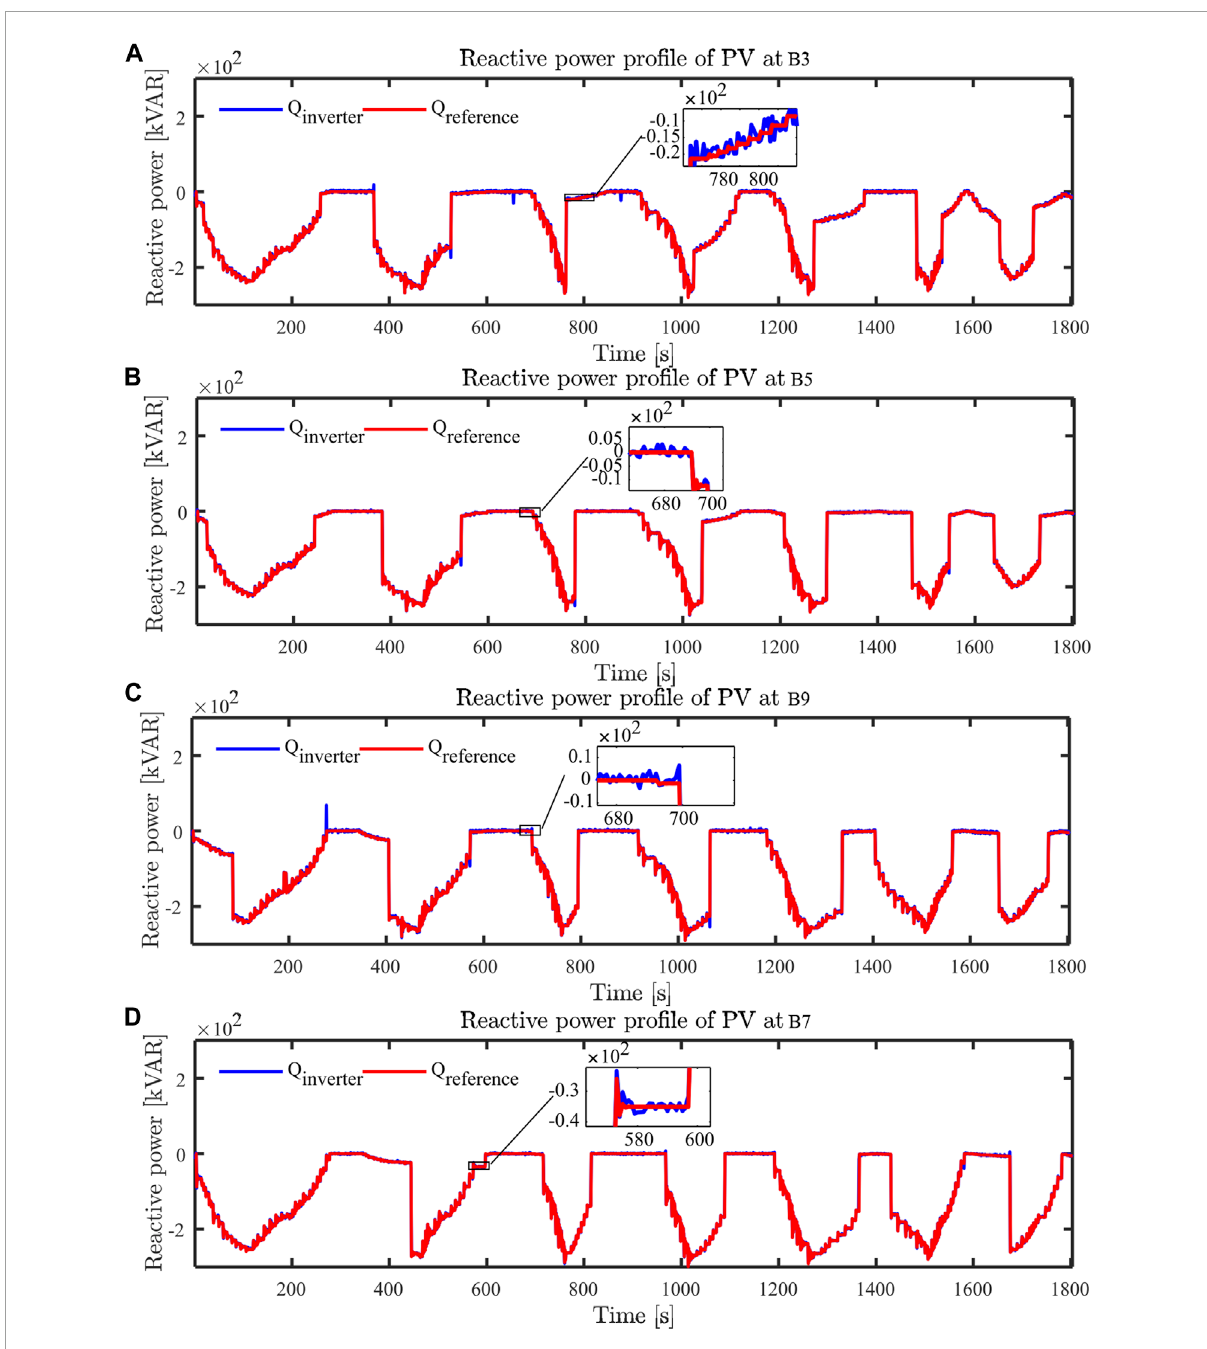
FIGURE 9 Reactive power profile of PV at (A) B3, (B) B5, (C) B9, and (D) B7.